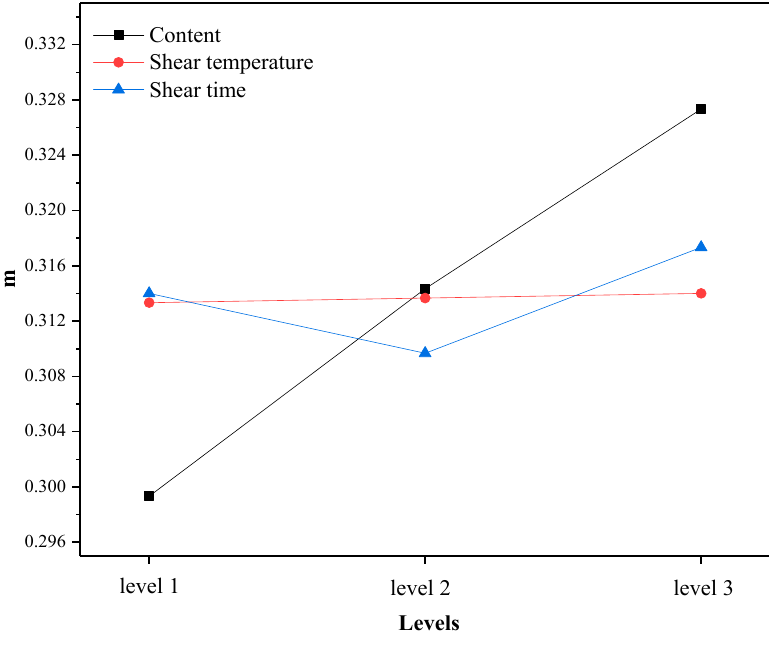
Figure 6. The variation of the mean m with the levels.